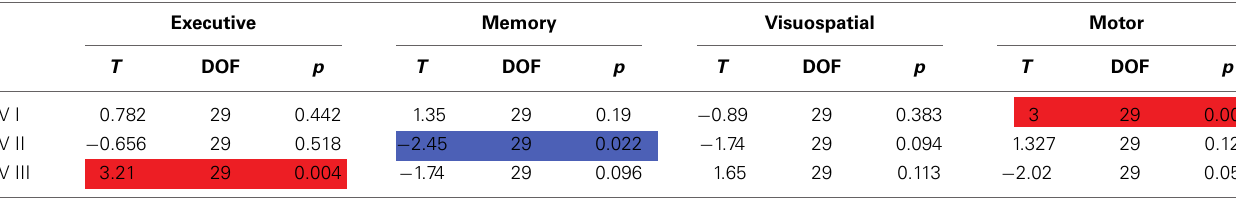
Table 2 | Associations between component scores and behavioral data: nodal